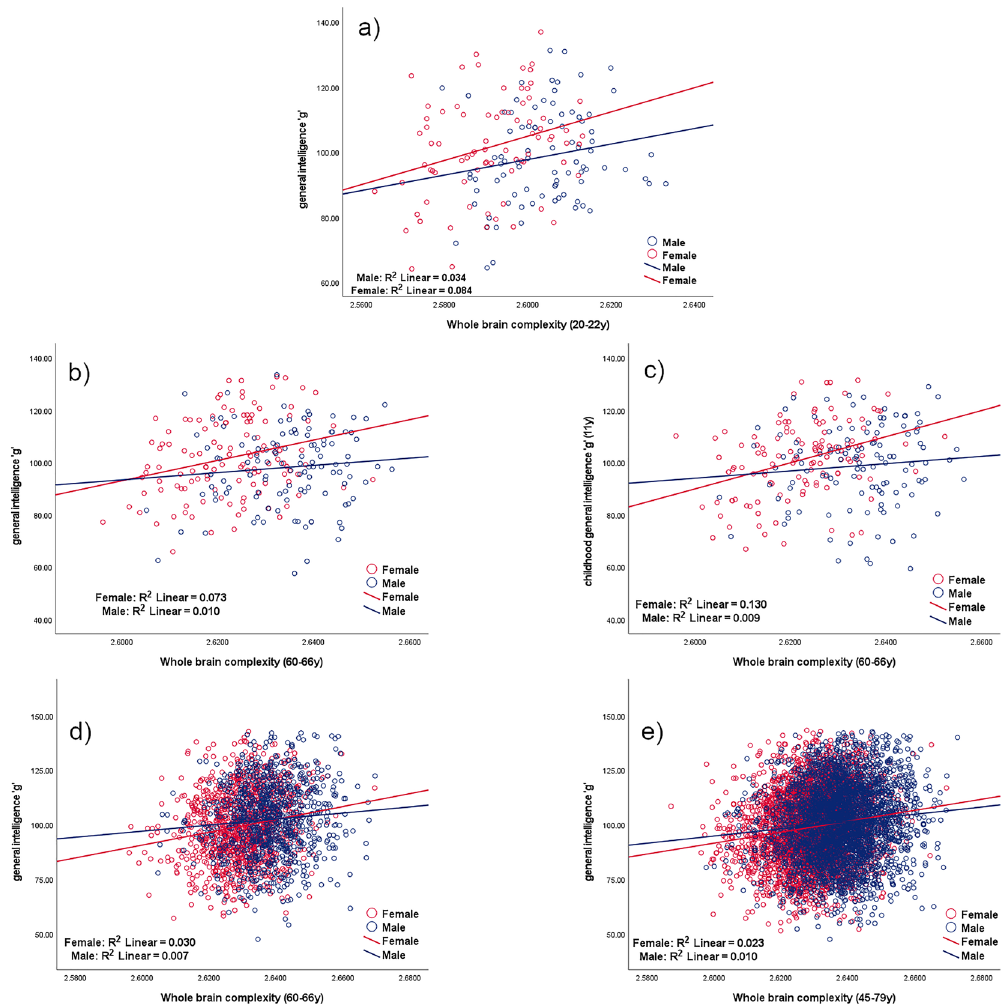
Figure 1. Correlations between whole brain complexity and general intelligence g according to sex. ( a ) Mysore Parthenon Cohort (MPC)—correlation between whole brain complexity and general intelligence g for women (red) and men (blue) at age 20–22. ( b , c ) ACONF cohort—correlation between whole brain complexity and general intelligence g at age 60–66 ( b ) and at age 11 ( c ) for women (red) and men (blue). ( d , e ) UK Biobank— correlation between whole brain complexity and general intelligence g at age 60–66 ( d ) and at age 45–79 ( e ) for women (red) and men